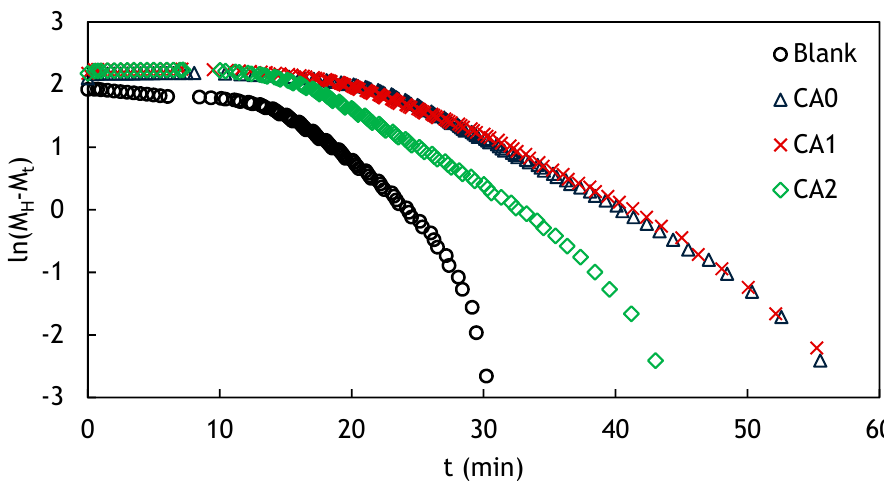
Figure 14. Kinetic plot of the composite compound added with NR-g-St at various compositions, which are measured at 150 °C.